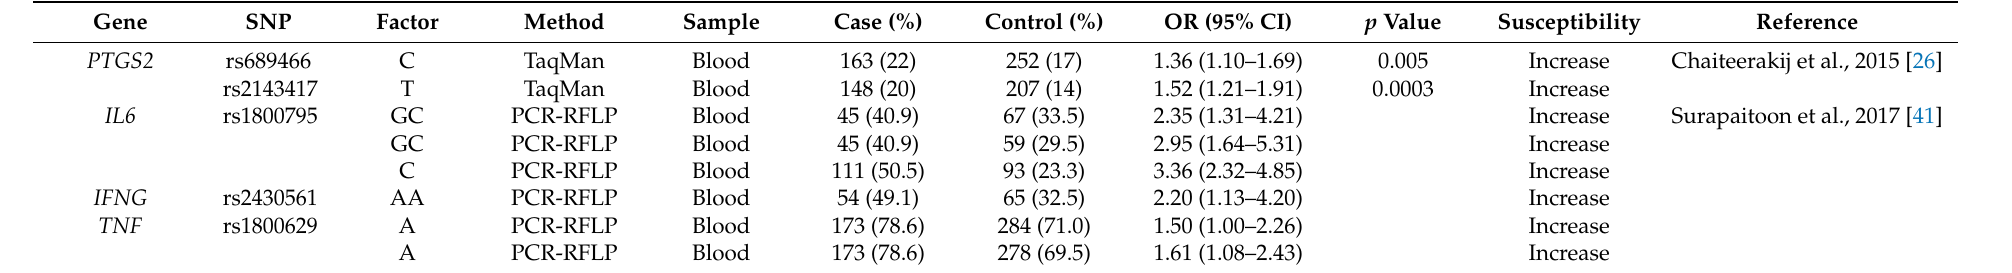
Table 2. The relationship between the SNPs in inflammation-related genes with the susceptibility of CCA. Various studies investigated SNPs in inflammation-related genes related to the susceptibility of CCA.